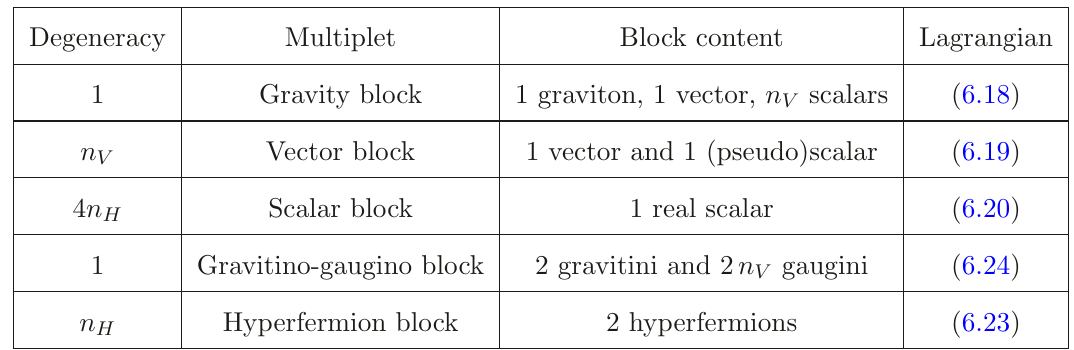
Table 5 . Decoupled quadratic fluctuations in